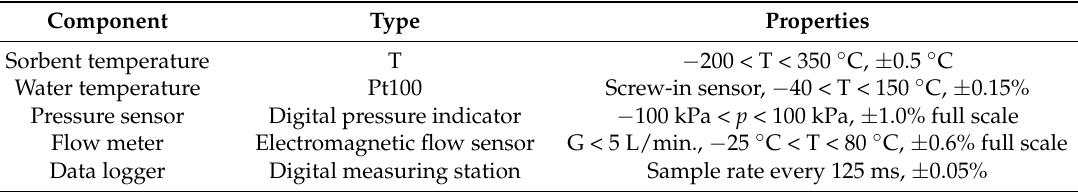
Table 3. Description of each measurement parameter.